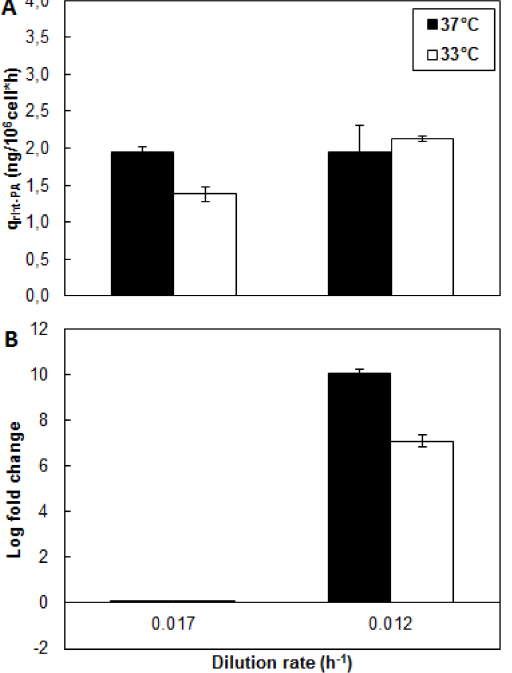
Figure 2. Differential effect of culture temperature and dilution rate on protein production and mRNA expression of rht-PA. A: Specific productivity of rht-PA. B: Log fold change of mRNA of rht-PA. & Condition 37 u C; % Condition 33 u C.